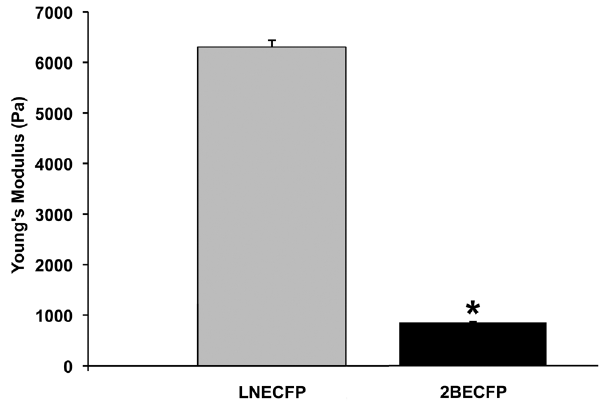
Figure 5. Young’s modulus (tensile modulus) of LNECFP and 2BECFP cells. Using an AFM cantilever, the Young’s modulus of beta-2 overexpressing 2BECFP cells (850 Pa) was found to be significantly lower than the Young’s modulus of LNECFP cells (6294 Pa) (P , 0.05). Data represented as average Young’s modulus 6 SEM (n=3).